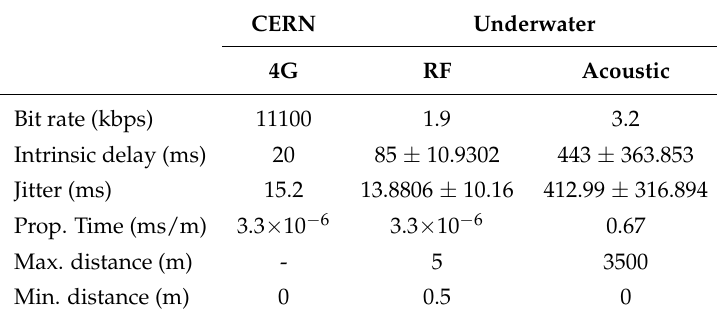
Table 3. Results obtained in underwater communication